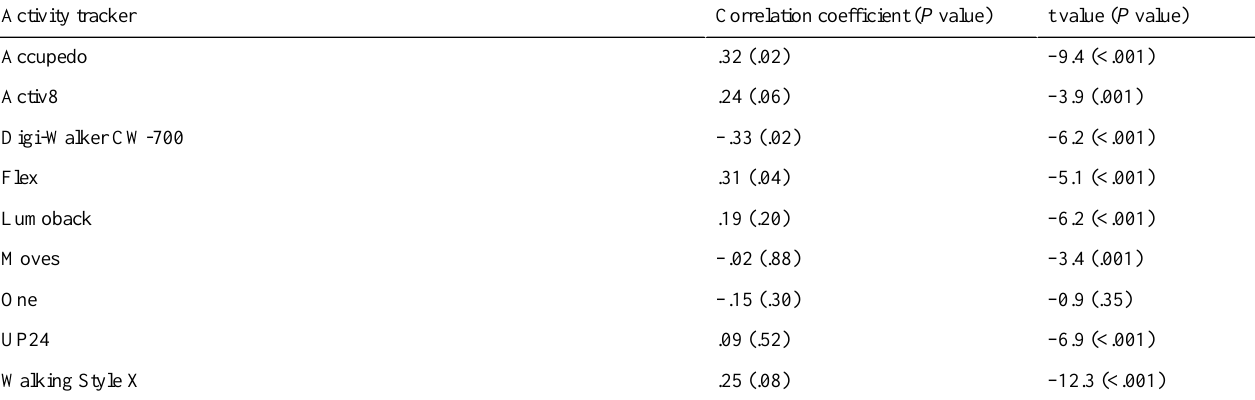
Table 5. Correlation coefficient of the activity trackers and the gold standard for step count.